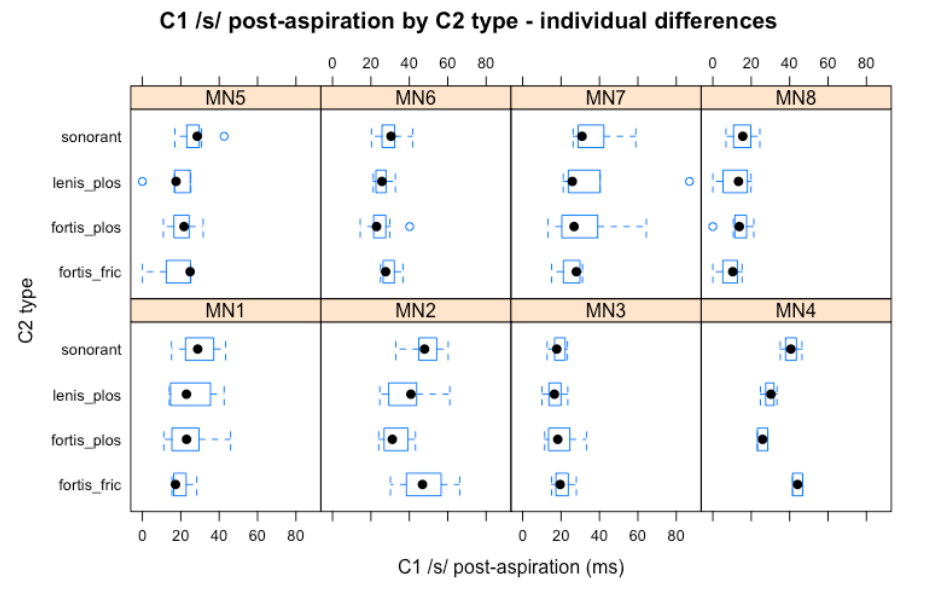
Figure 4: Effects of C₂ type on C₁ /s/ post-aspiration duration by individual